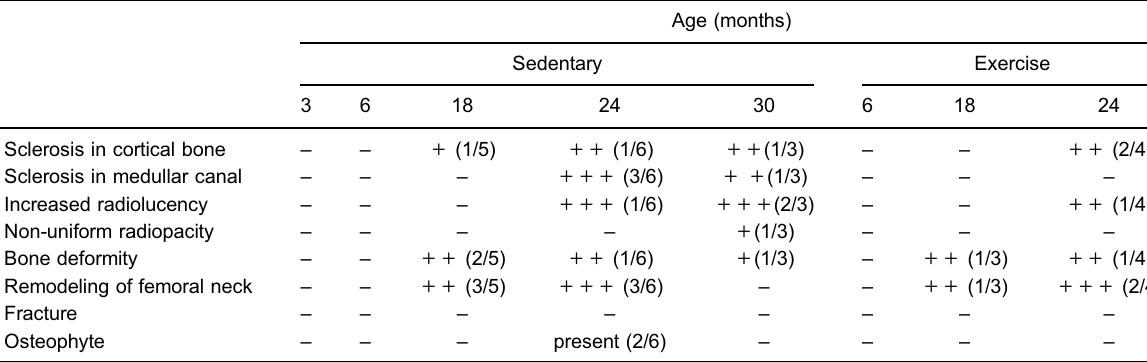
Table 1. Radiographic measurements of femur from Wistar rats of different